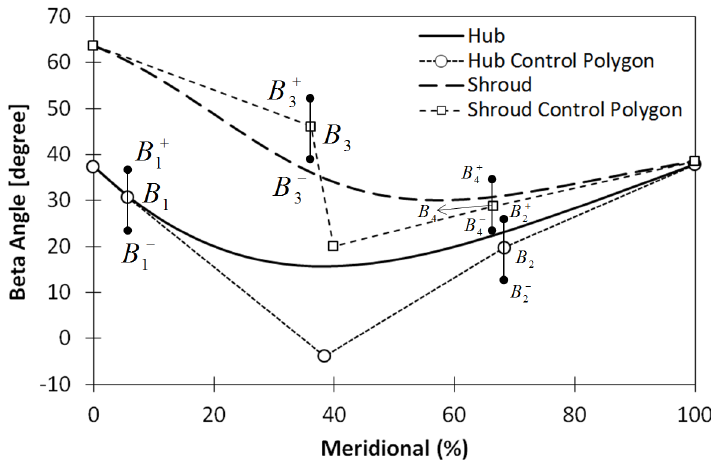
Figure 4. β angle distribution